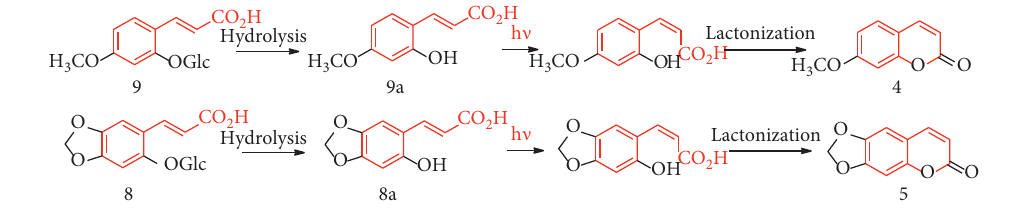
Figure 3: Plausible biosynthesis of 4 from 9 and 5 from 8 in E. triplinerve . Table 1: α -glucosidase inhibitory activity of compounds 4–9 and 11 .